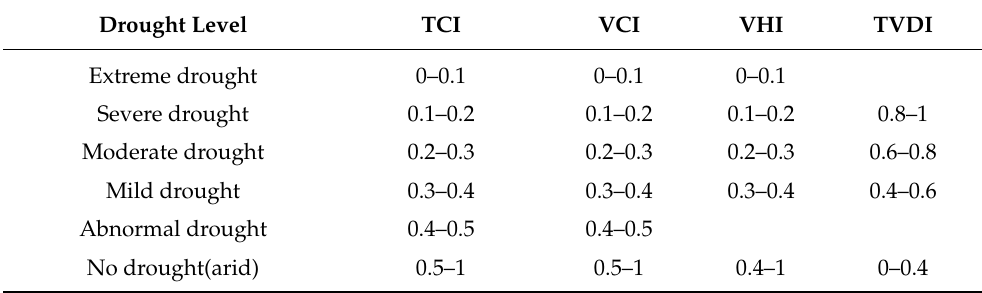
Table 5. Drought level classification scheme [66].